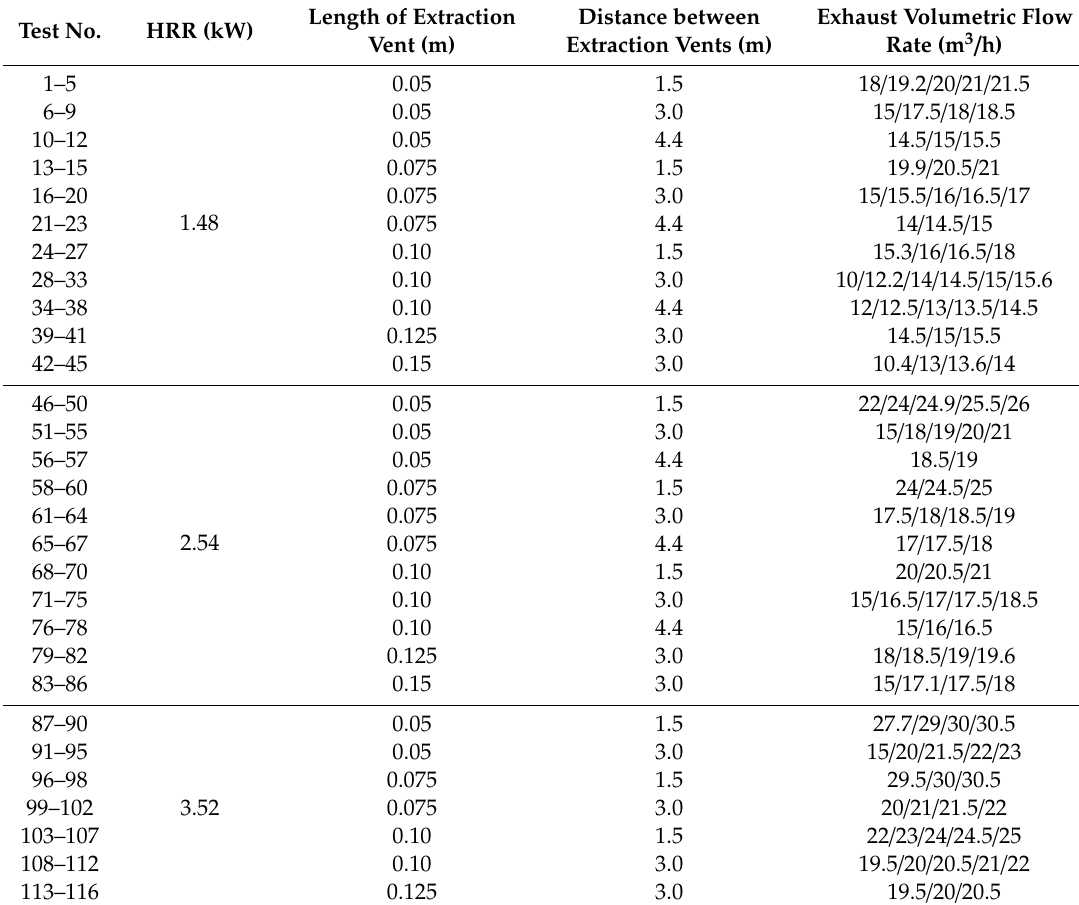
Table 2. Summary of experimental